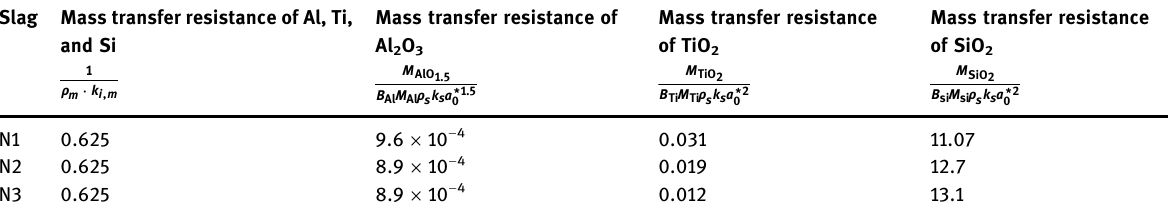
Table 5: Mass transfer resistance of components in the alloy and slag Slag Mass transfer resistance of Al, Ti, and